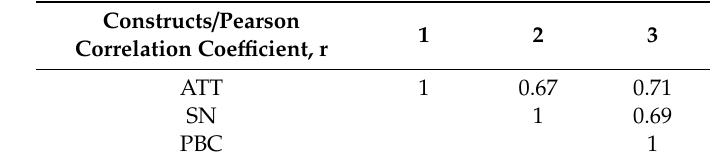
Table 5. Discriminant Validity among Latent Variables of Confirmatory Factor Analysis for the Validation Sample ( n = 323).